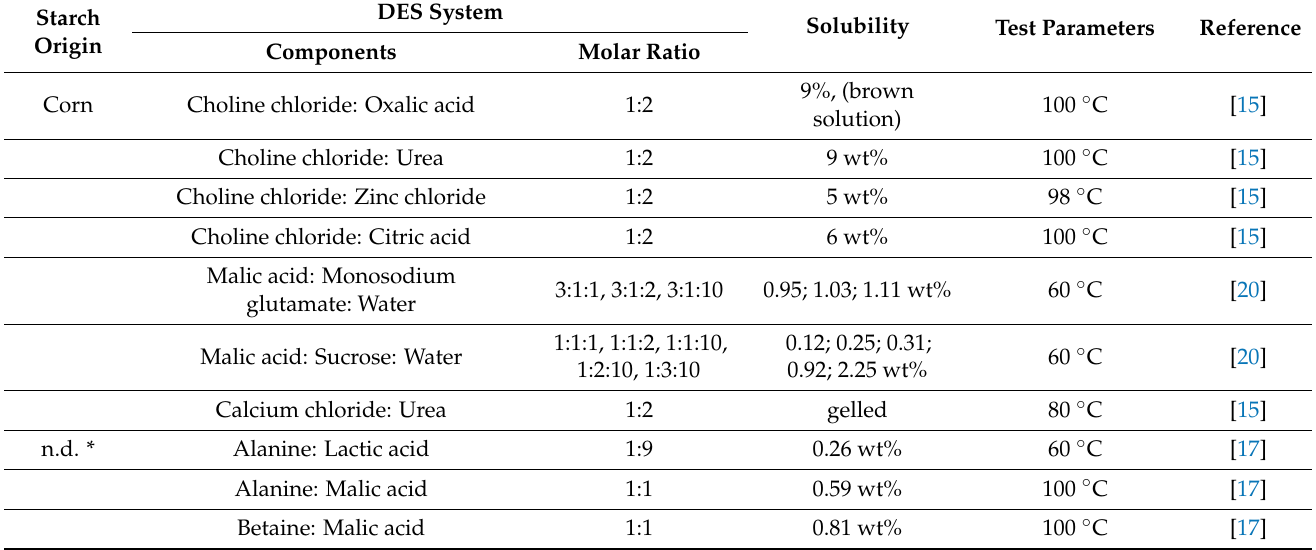
Table 1. Deep eutectic solvents used as starch